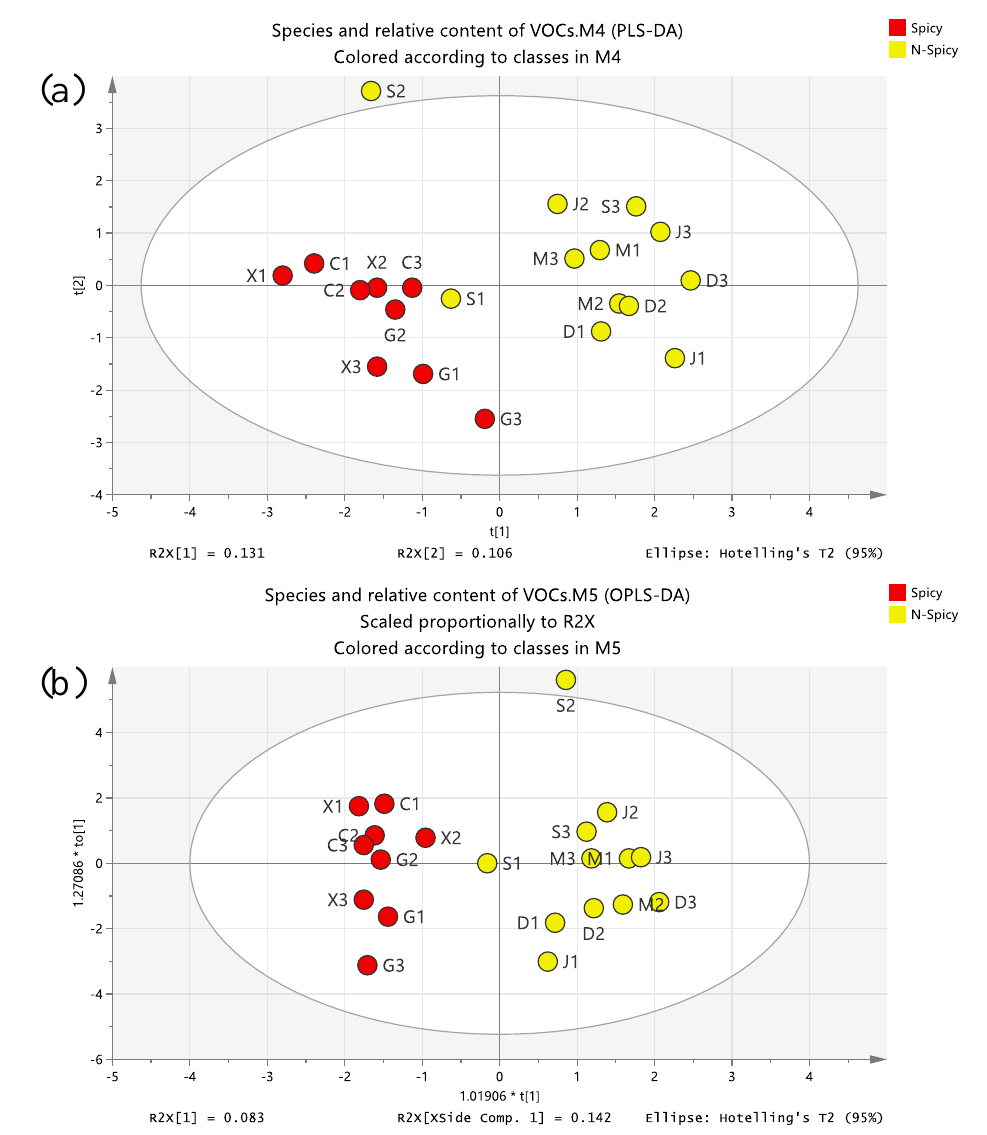
Figure 6. PLS-DA ( a ) and OPLS-DA ( b ) diagrams of spicy and non-spicy (N-Spicy) regions.